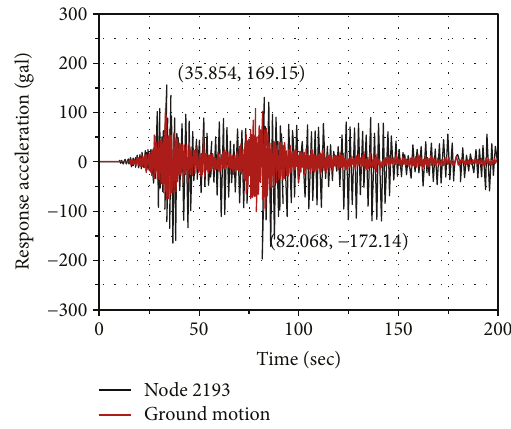
Figure 20: Time history of response horizontal acceleration for node 2193.